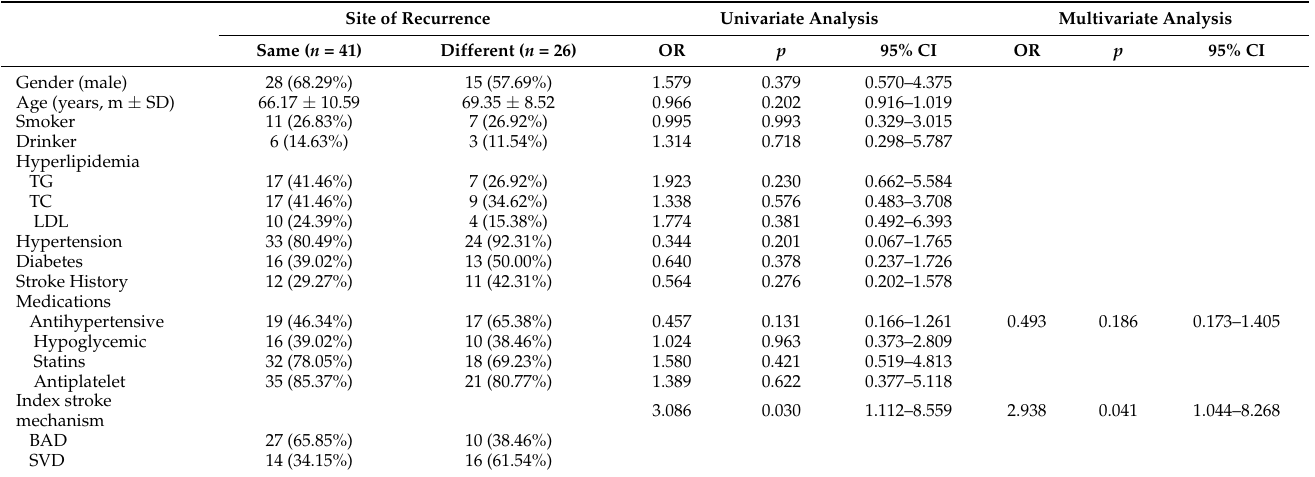
Table 1. Site of